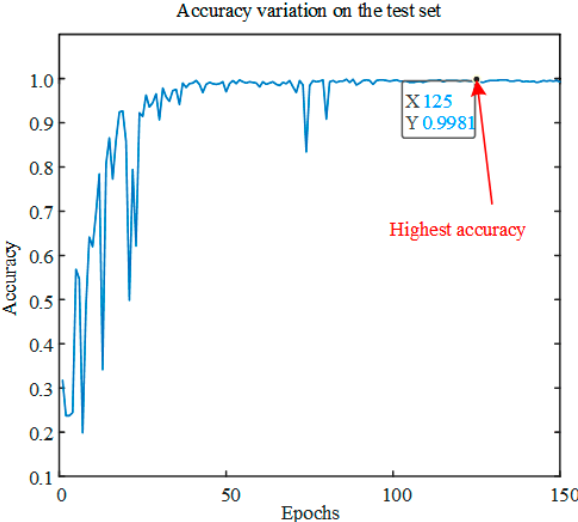
Table 7. Results of 10 experiments.